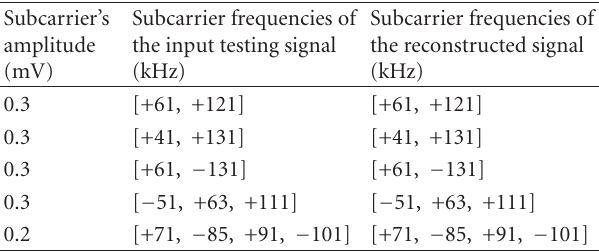
Table 1: Testing results of the